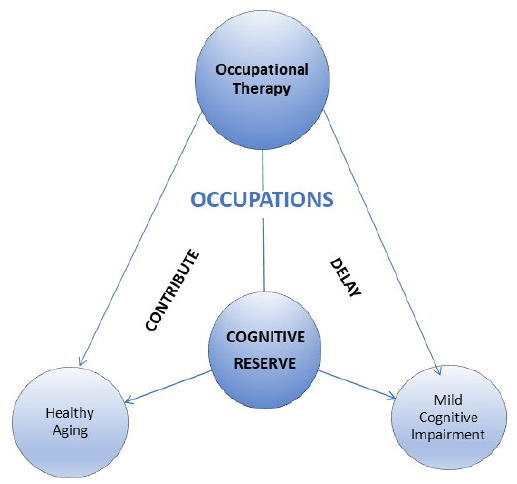
Figure 1. Interaction between occupational therapy and cognitive reserve.